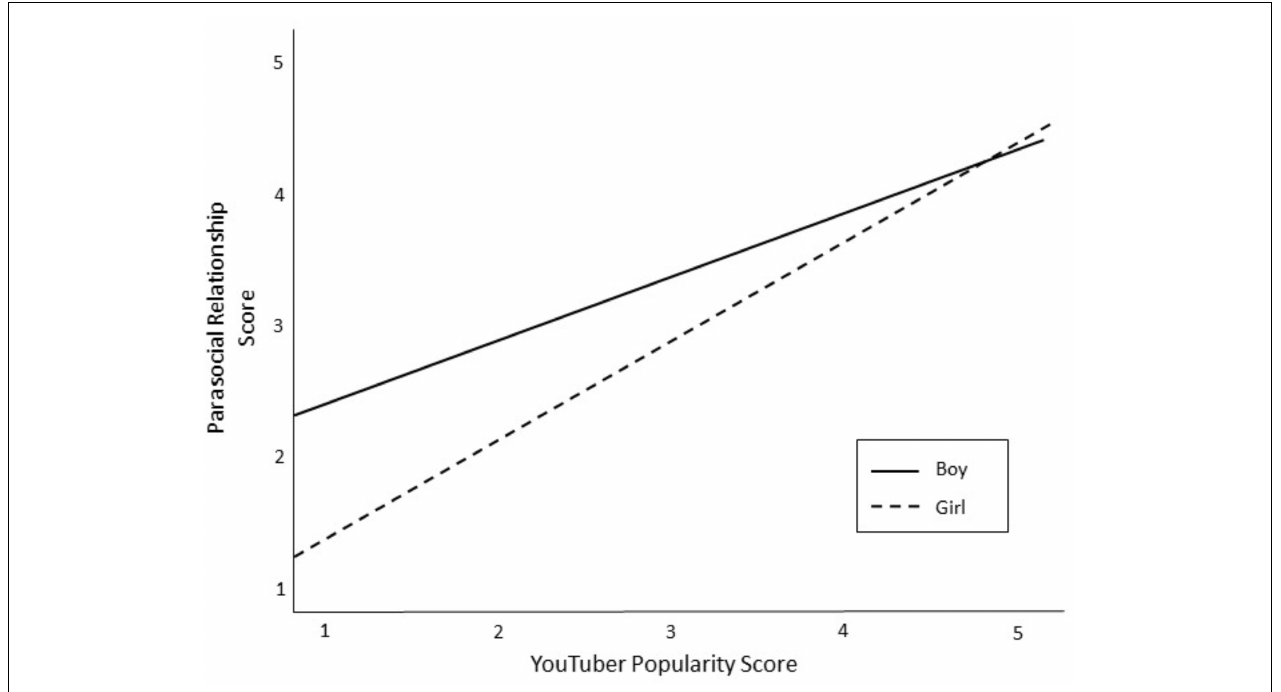
FIGURE 4 | The relationship between YouTuber popularity and PSR as moderated by gender of child.